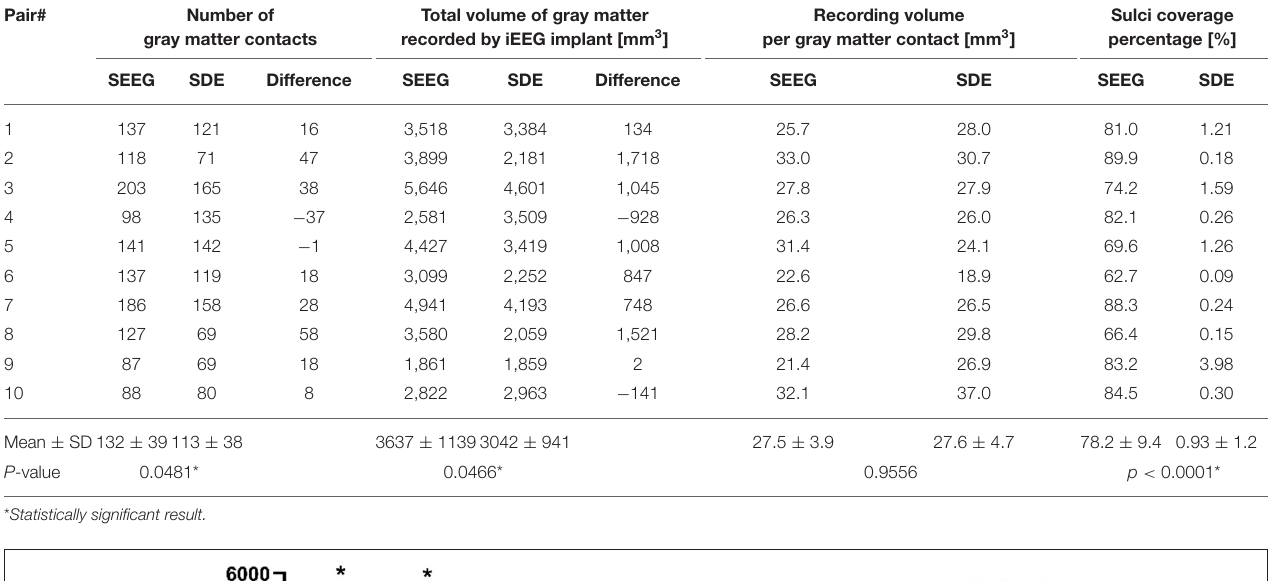
TABLE 2 | Comparison of the number of gray matter contacts, the total volume of gray matter recorded, the average recording volume per gray matter contact, and the percentage of sulcal coverage between SEEG and SDE implants. Pair#